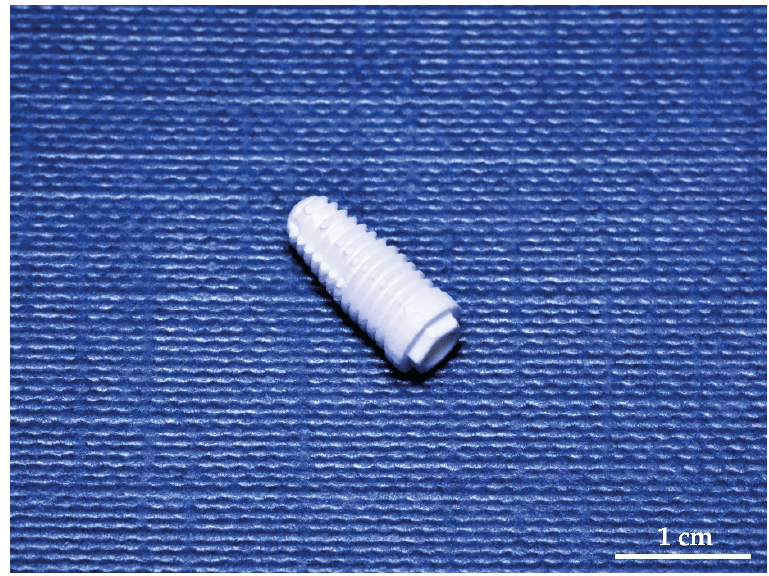
Figure 6. Endosseous dental implant in ATZ printed with the DLP technique.